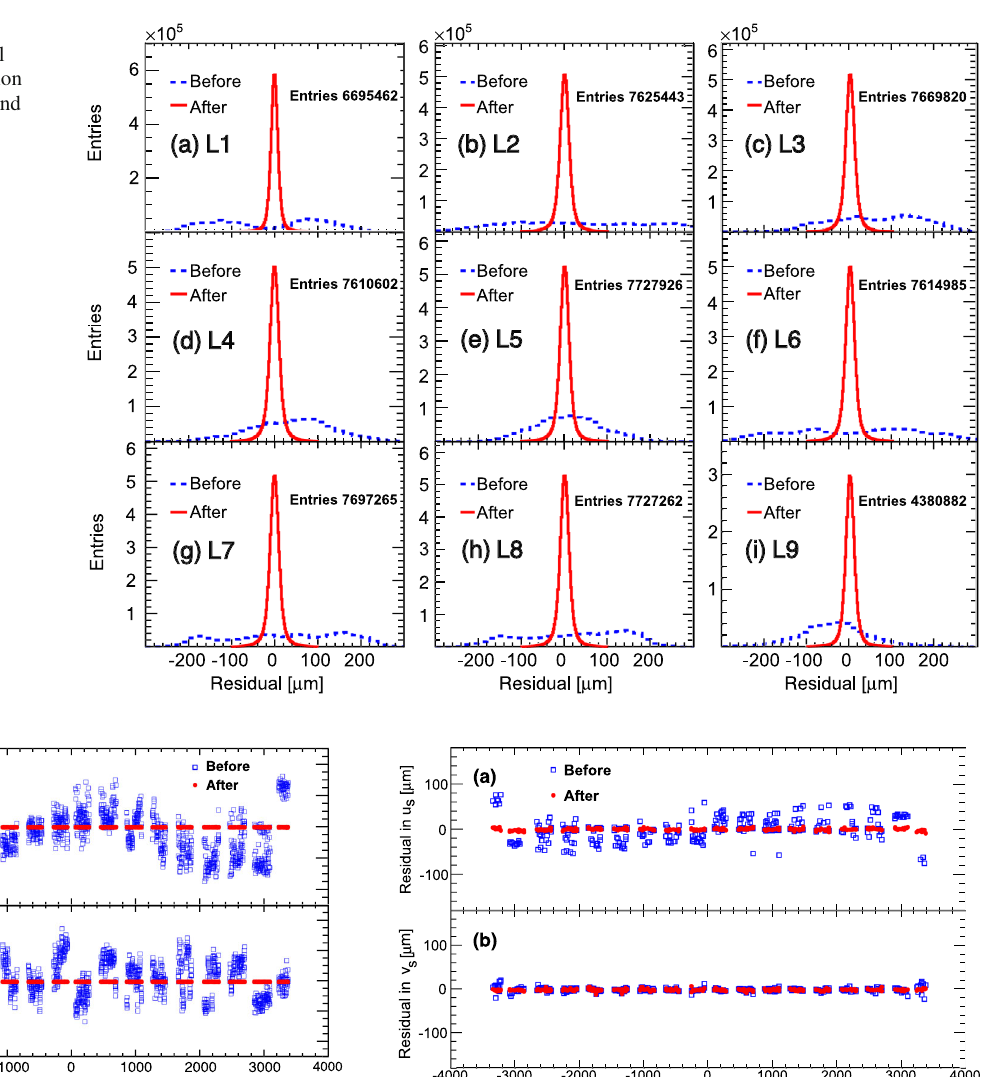
Fig. 10 The residual biases of the individual sensors in a the u s direc- tion and b the v s direction before (open squares) and after (full circles) the test-beam alignment. A circle or square represents the residual bias of each sensor. The circles or squares of a common group are the sen- sors from the same half of a tracker layer. The sensor ID is defined as ( sensor + 20 × ladder + 400 × layer ) × half , where sensor is the sensor number [ 1 ... 15 ] , ladder is the ladder number [ 1 ... 13 ] , layer is the layer number [ 0 ... 8 ] , and half is − 1 for the ladders located on the negative half ( u 0 L < 0 ) and + 1 on the positive half ( u 0 L > 0 ) of a layer